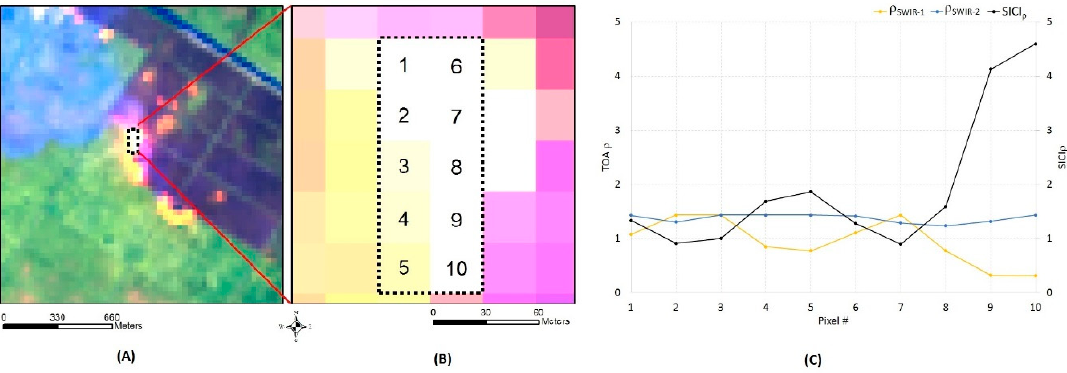
Figure 3. ( A ) Sample of combustion area in the 764 RGB image of Landsat-8 on 19 August 2015 which had high reflectance of SWIR-1 and SWIR-2, ( B ) the enlargement of combustion areas showing 10 sample pixels, ( C ) the extracted SWIR-1 and SWIR-2 reflectances with SICI ρ values; pixel#2, #3, and #7 had SICI ρ ≤ 1.